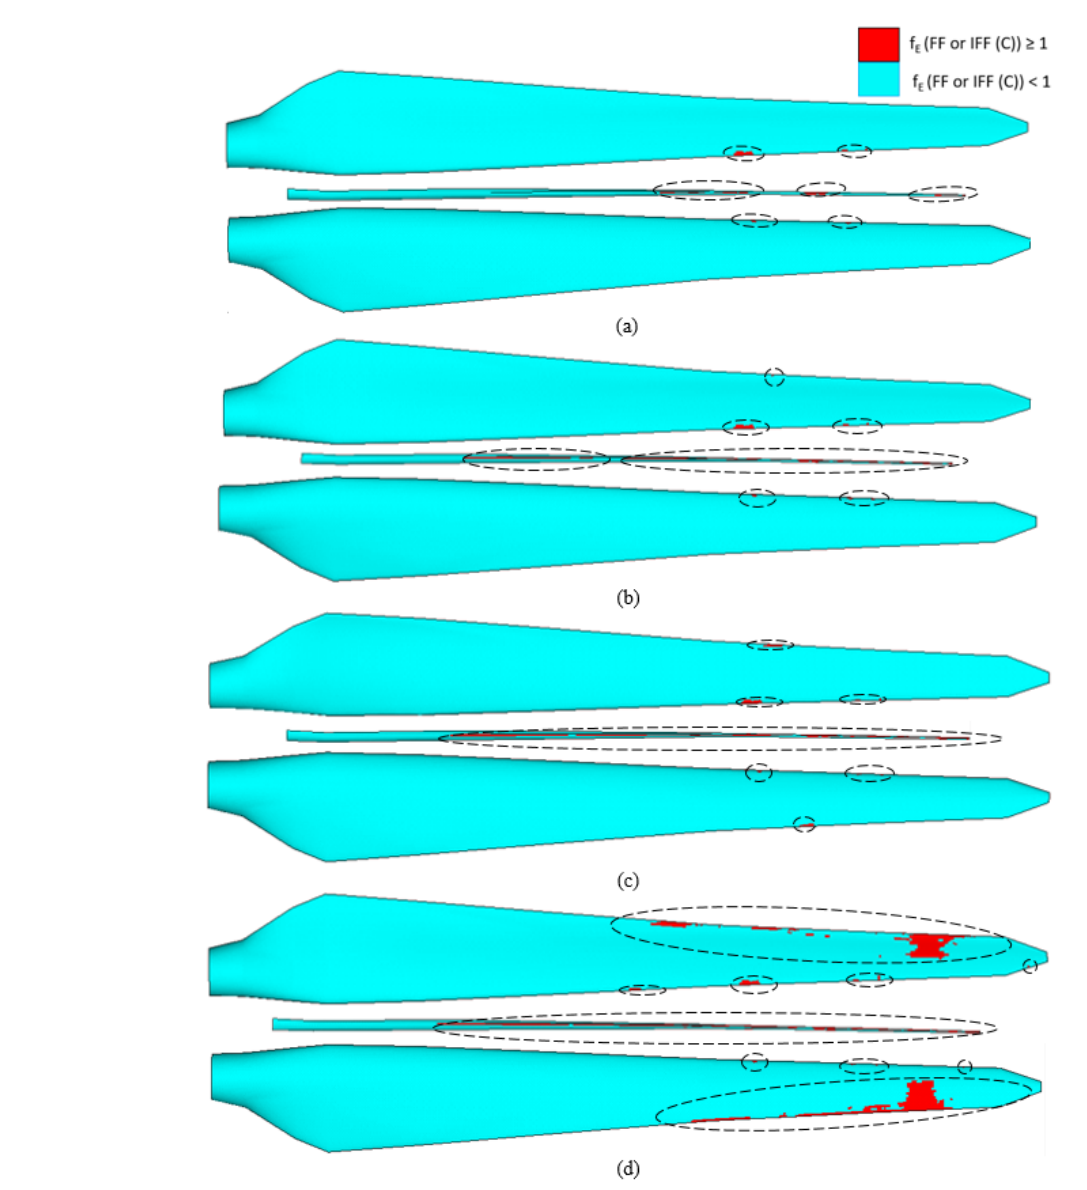
Figure 17. Element failure progression in the pressure side, internal flange and suction side of the blade (from top to bottom in a panel) at (a) 75%, (b) 100%, (c) 105% and (d) 116% of extreme flapwise